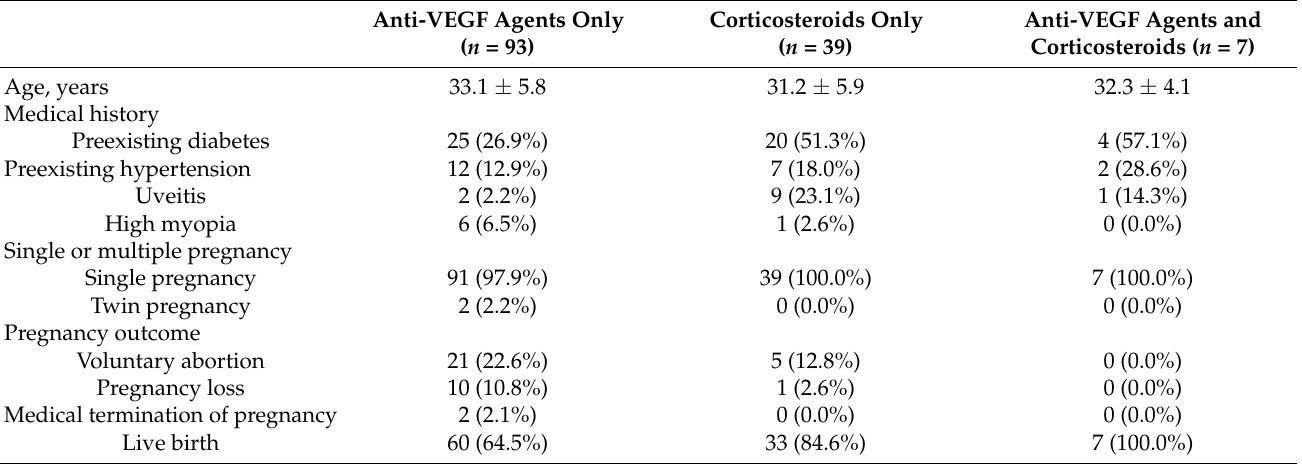
Table 3. Clinical characteristics and pregnancy outcomes of women who had anti-VEGF or cor- ticosteroid IVTs during pregnancy or in the month preceding pregnancy between 2009 and 2018 ( n =